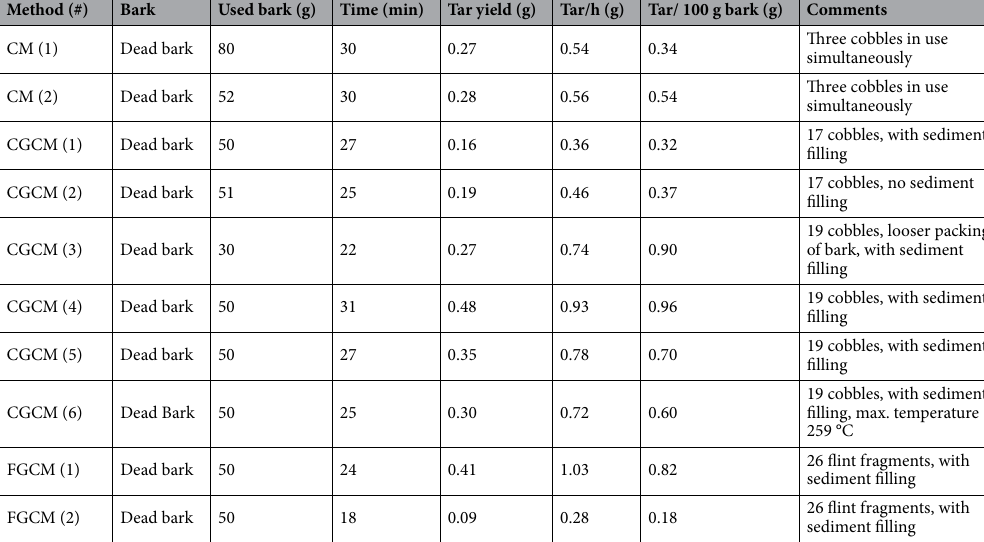
Table 1. Results of eight birch tar production experiments with the condensation method (CM), the cobble- groove condensation method (CGCM) and the flint-groove condensation method (FGCM). Three cobbles were used at the time for the condensation